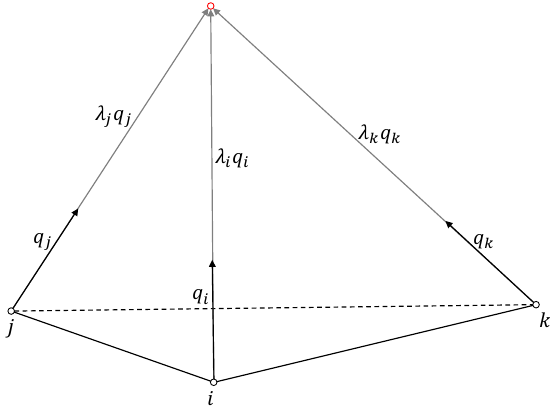
Figure 1. Three cameras 𝑖 , 𝑗 and 𝑘 casting rays 𝑞 towards an observed object point (red). When scaled by factors 𝜆 , the rays should intersect in this